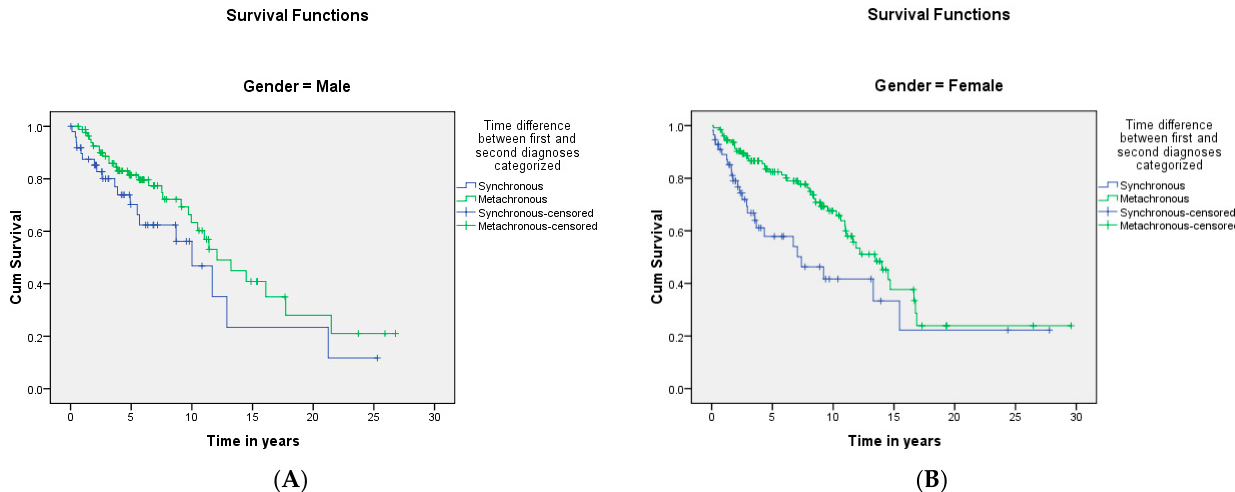
Figure 8. ( A , B ) shows the difference in survival when classified based on the MPM category by gender. The median survival time was 10 ± 1.7 and 12.1 ± 1.6 years for synchronous and metachronous malignancies, respectively, in the males, and in the females, the median survival time was 7.4 ± 2.6 and 13.5 ± 1.3 years for synchronous and metachronous malignancies, respectively. A significant difference was detected with the log-rank test ( p = 0.002).